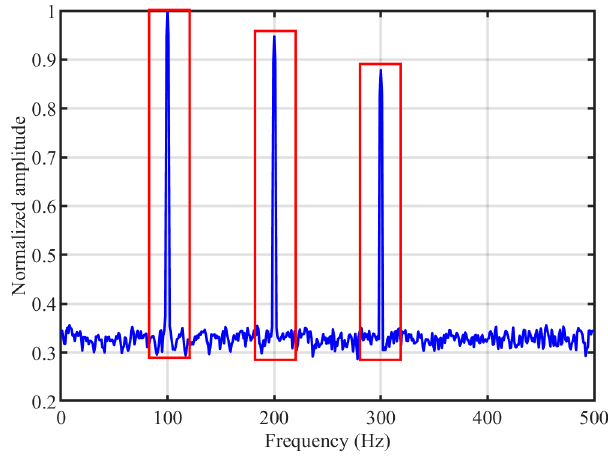
( b ) Figure A1. Phase distribution on the power spectrum: ( a ) phase variation with segment; ( b ) noise phase histogram. Appendix B. In ‐ Band SNR In line ‐ spectrum detection, the in ‐ band SNR is usually used to describe the relative magnitude of the line spectrum and the continuum spectrum noise. The in ‐ band SNR is defined as the ratio of the power at a line ‐ spectrum frequency point to the average power of the noise within a certain bandwidth. The calculation method is shown in Figure A2. The noise is additive white Gaussian noise, and only the frequency point at which the line spectrum peak is located is selected; then, noise frequency points within a certain band ‐ width around this are used to calculate the in ‐ band SNR. The red boxes in Figure A2 show the range of the frequency points selected to calculate the in ‐ band SNR. The in ‐ band SNR equation is: